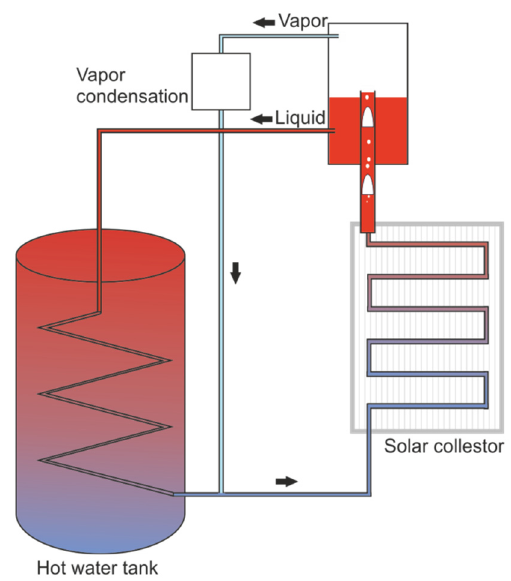
Figure 3. Diagram of a solar heater with a vapor lift pump (The figure is based [30]).